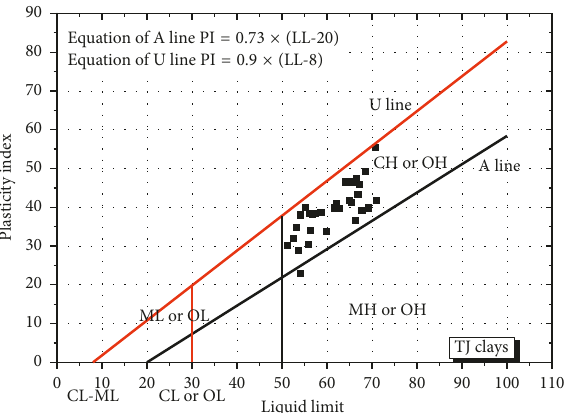
Figure 2: Plasticity chart of the tested Tianjin